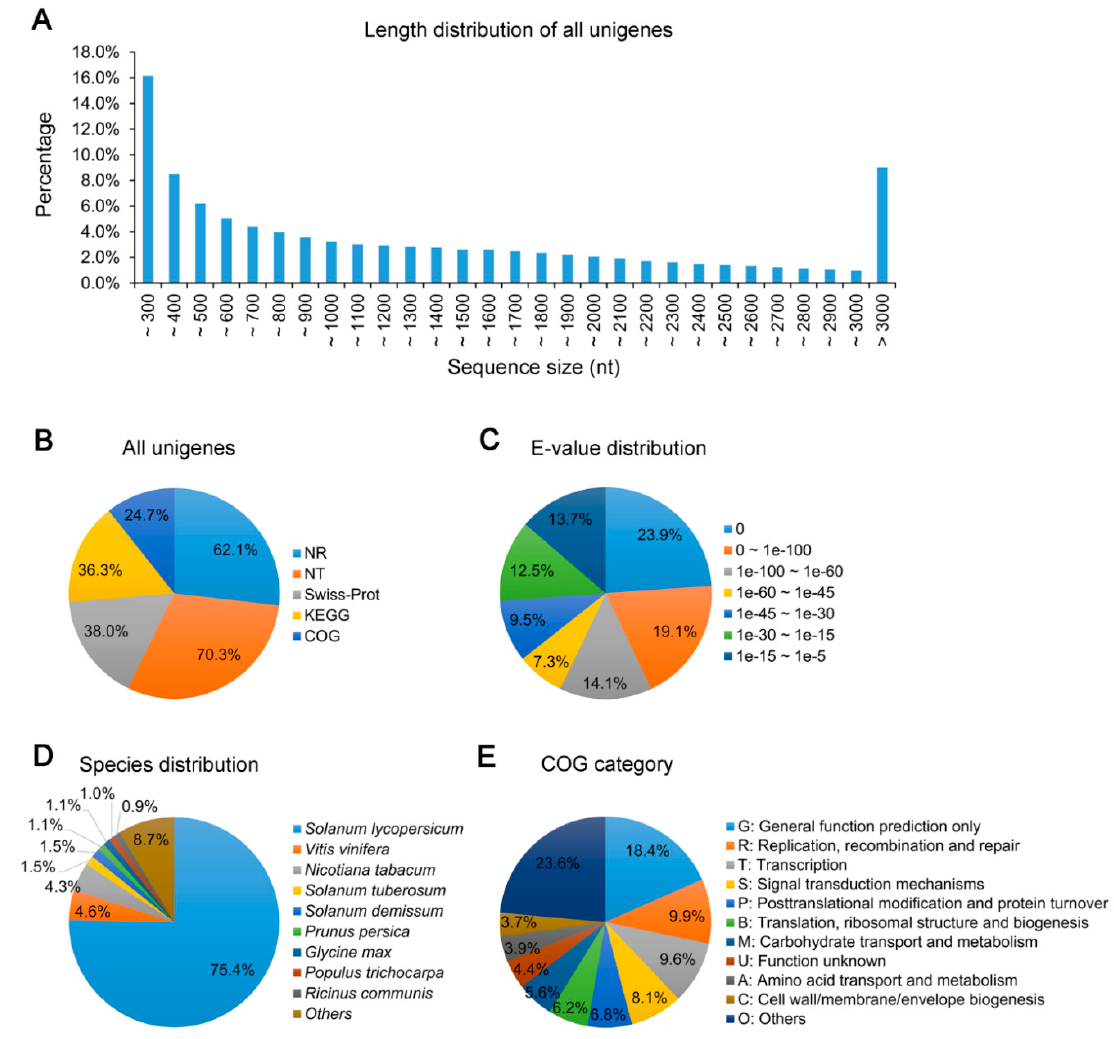
Figure 2. Illumina sequencing of leaves of N. benthamiana in response to virus infections. ( A ) The length distribution of all assembled unigenes. ( B ) The number of unigenes annotated by different databases, including NR, NT, Swiss-Prot, Kyoto Encyclopedia of Genes and Genomes (KEGG) and COG. ( C ) E-value distribution of all NR-annotated unigenes. ( D ) Species distribution of all NR-annotated unigenes. ( E ) Category classification of all COG-annotated unigenes.